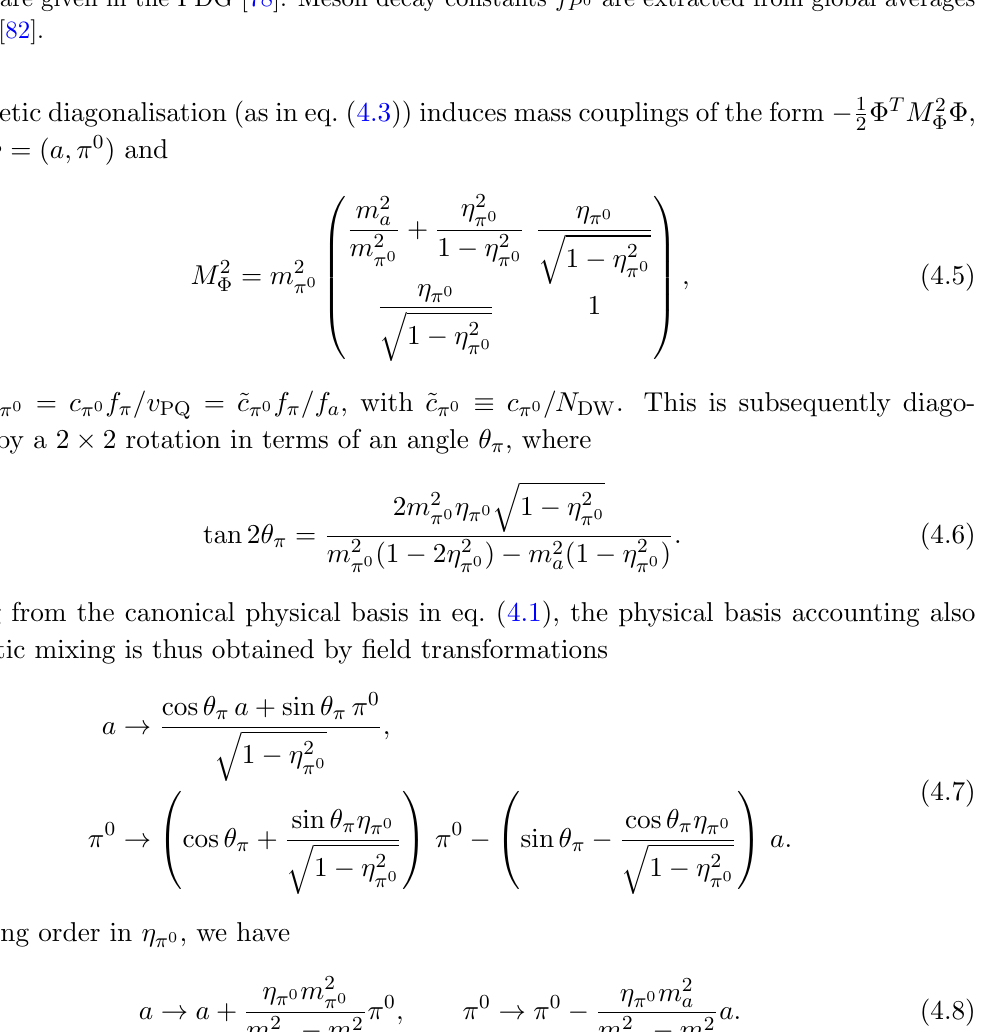
are extracted from global averages P 0